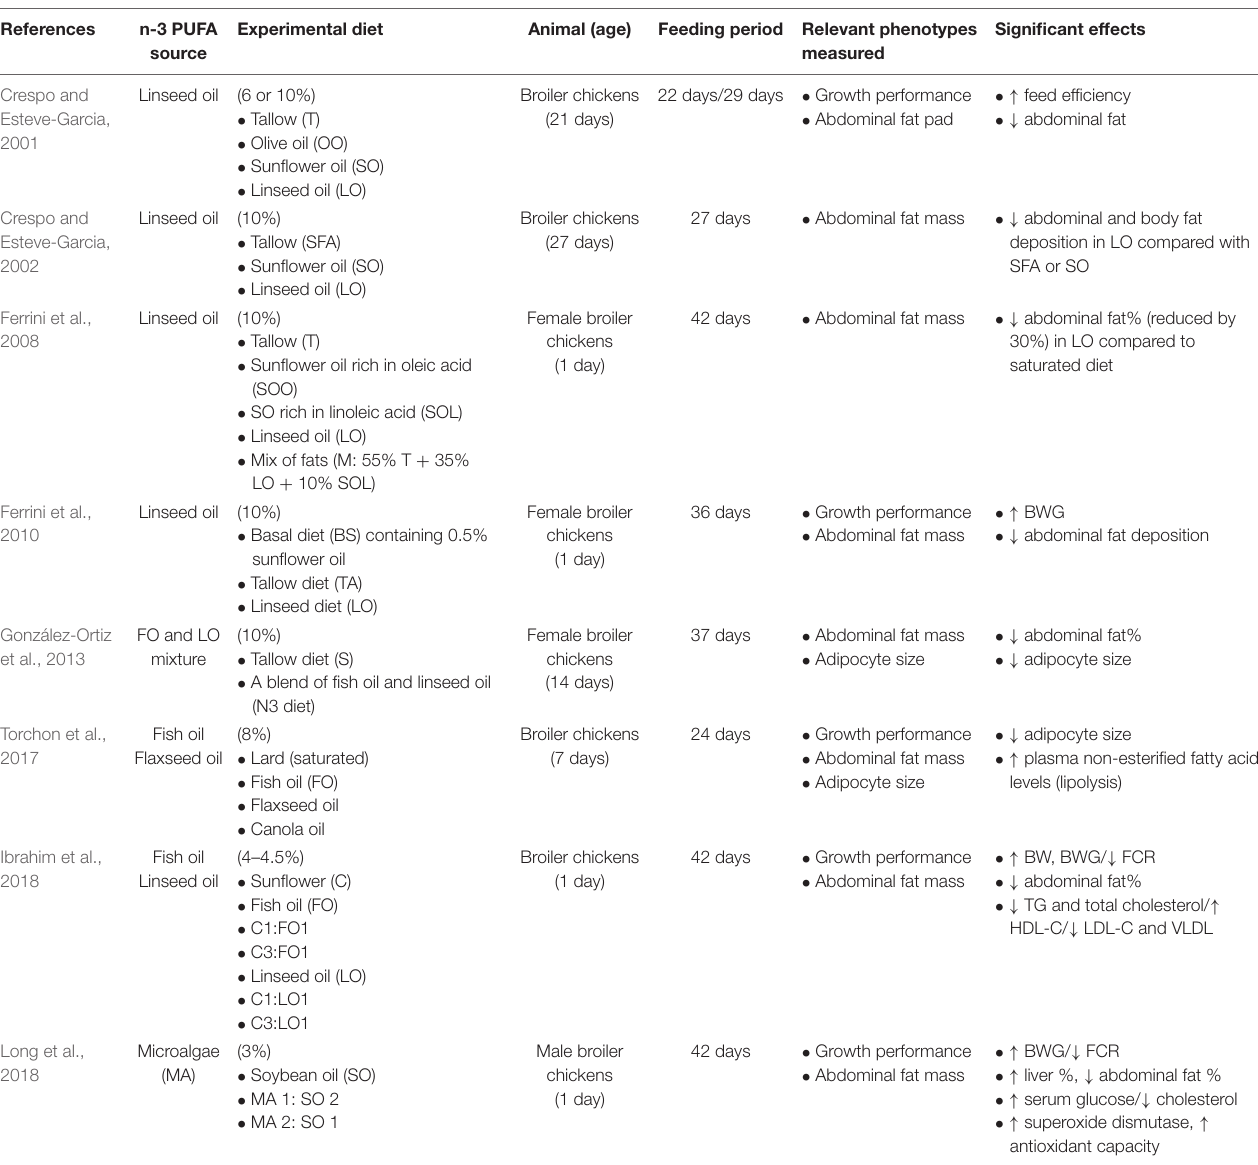
TABLE 1 | Studies that investigated different dietary sources of n-3 PUFA and fat deposition in broiler